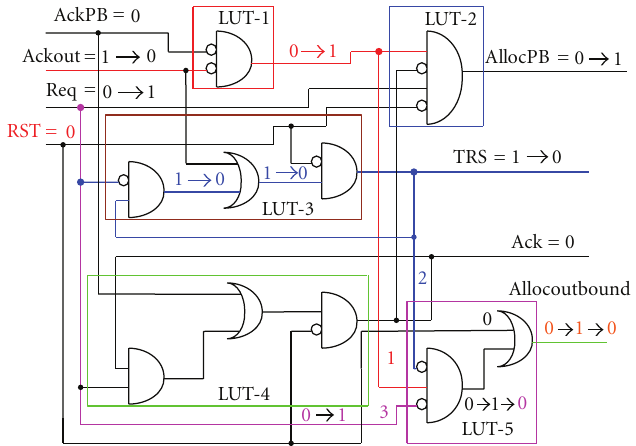
Figure 14: Logic circuit of the mp-for-pkt: map view—Altera (behavior 1 → 2).